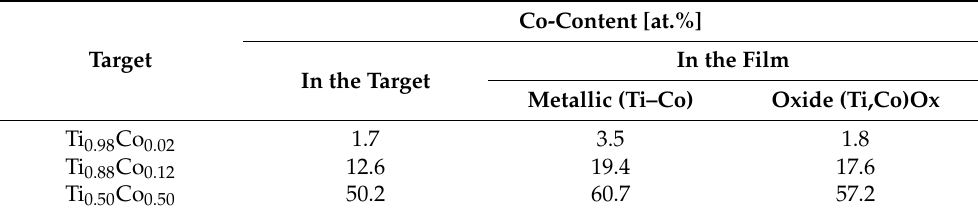
Table 1. Material composition of thin-film coatings (metallic and oxide) based on Ti and Co and targets used for their deposition by magnetron sputtering. Co-Content [at.%] Target In the Film In the Target Metallic (Ti–Co) Oxide (Ti,Co)Ox Ti 0.98 Co 0.02 1.7 3.5 1.8 Ti 0.88 Co